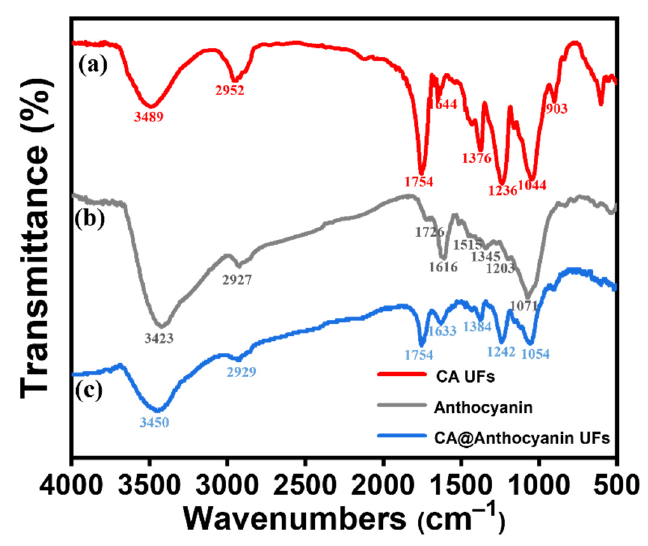
Figure 2. FTIR spectra of ( a ) CA UFs, ( b ) anthocyanin, and ( c ) CA@Anthocyanin UFs.